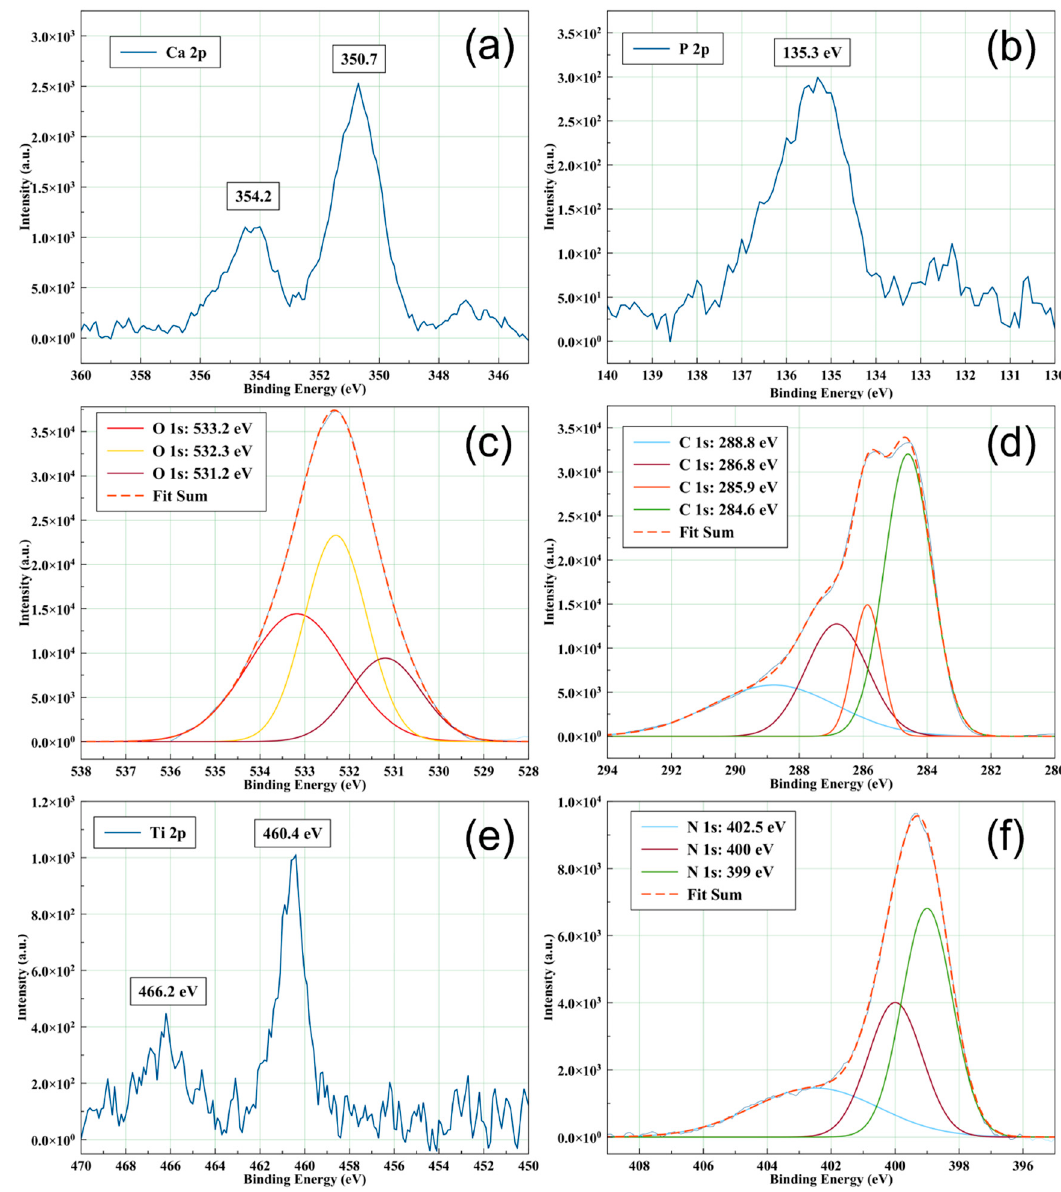
Figure 6. XPS high-resolution spectra: ( a ) Ca 2p, ( b ) P 2p, and ( e ) Ti 2p and XPS high-resolution deconvoluted spectra: ( c ) O 1s, ( d ) C 1s, and ( f ) N 1s for the CaP_1_CS.